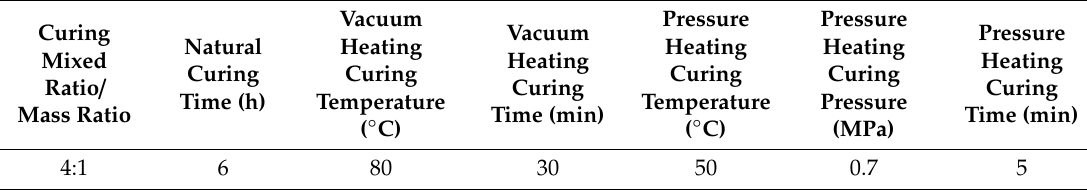
Table 3. Process parameters for preparing two-dimensional (2D)-CFRP composite materials by the VIHPS.